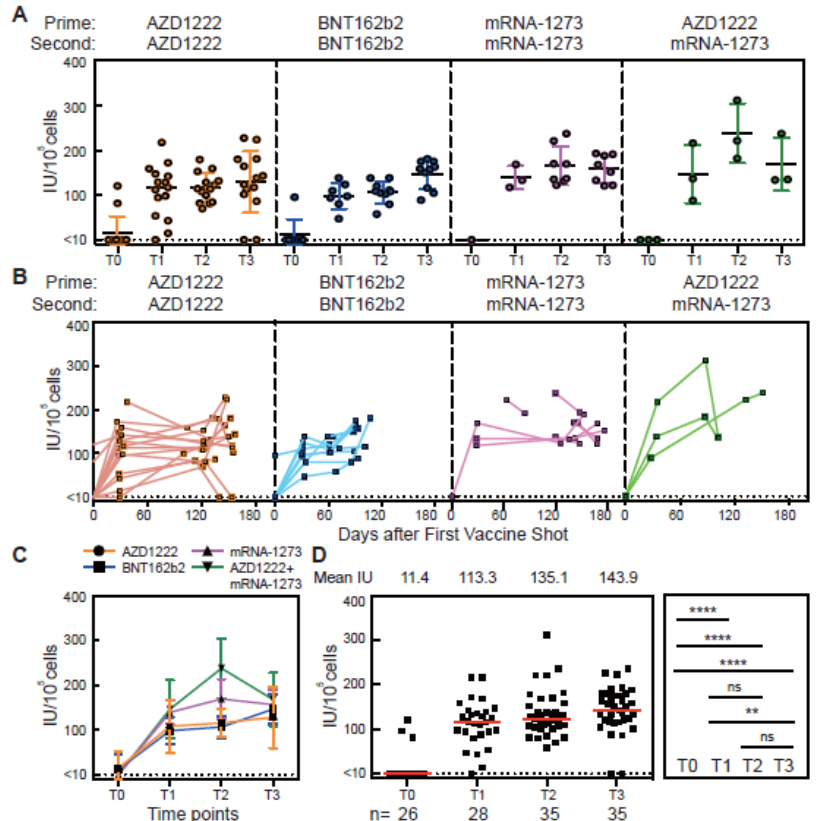
Figure 3. In vitro culture system to differentiate spike-RBD-specific cells into antibody secreting cells. ( A – C ) Concentration of neutralizing anti-spike-RBD IgG antibodies in culture supernatant over time from PBMC stimulated with R848, IL-2, IL-21, sCD40, and WT-RBD. ( D ) Total neutralizing anti-spike-RBD IgG concentrations in culture supernatant after 3 days of stimulation for each time point. The number of subjects (n) is shown below the graph. IU indicates the international units. The error bar indicates that the median and interquartile range. Statistics were calculated using the non-parametric Mann–Whitney test. The dotted line indicated the limit of detection (LOD) for the assay. ** p < 0.01; **** p < 0.0001; ns, no significant